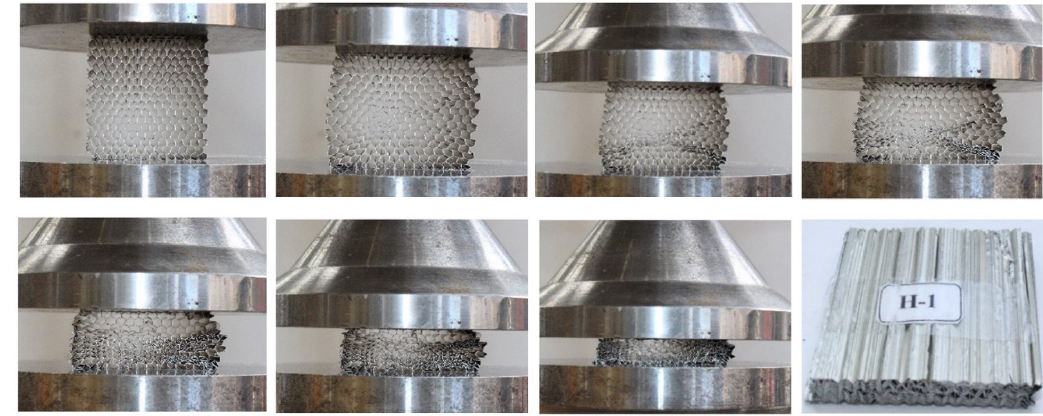
Figure 5. Stages of the failure mode of honeycomb specimen laterally